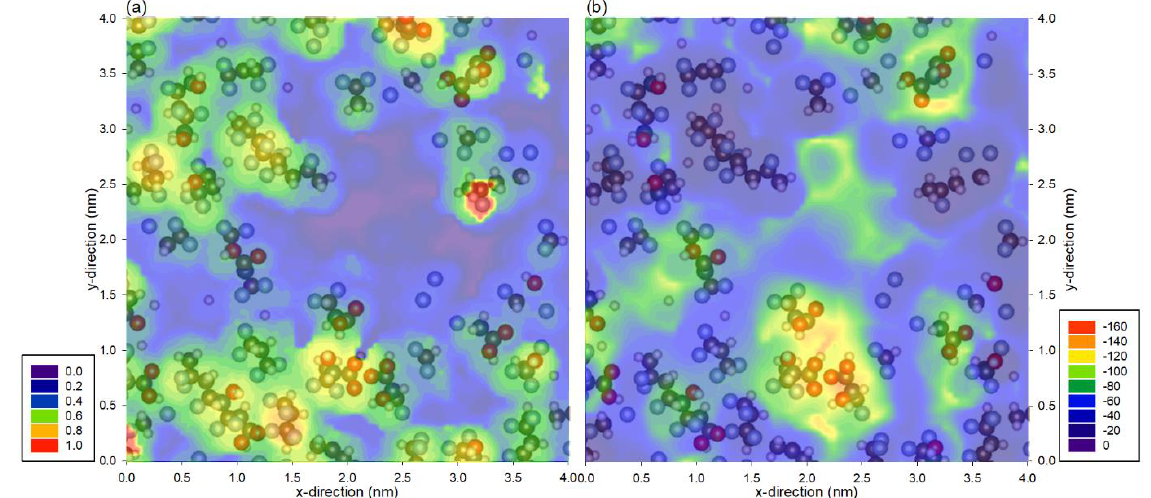
Figure 4. ( a ) Distance of the probe molecule and the ( b ) minimum total interaction energy between water probe molecule and the hydrophilic PVDF membrane. Note that the profiles are superimposed with hydrophilic PVDF atoms from the top 0.2 nm of the membrane, and the legends are represented in ( a ) nm and ( b ) kJ/mol.